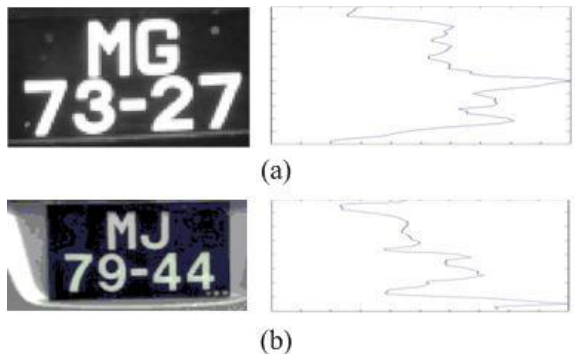
Figure 9 : Examples of horizontal projection result of two-row license plates. (a) Slanted case. (b) Undesired region is